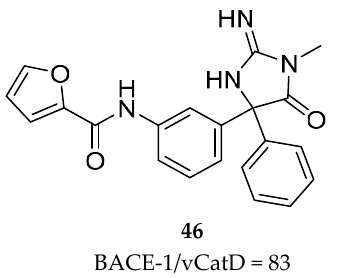
Figure 36. Iminohydantoin 46 previously developed by Merck.